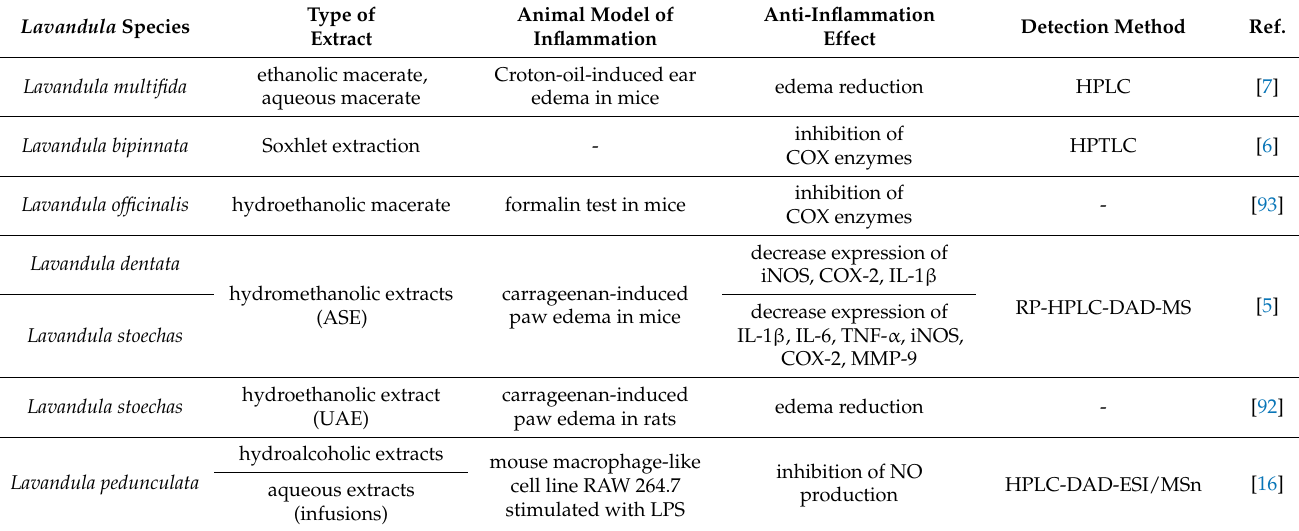
Table 5. Anti-inflammatory activity of Lavandula